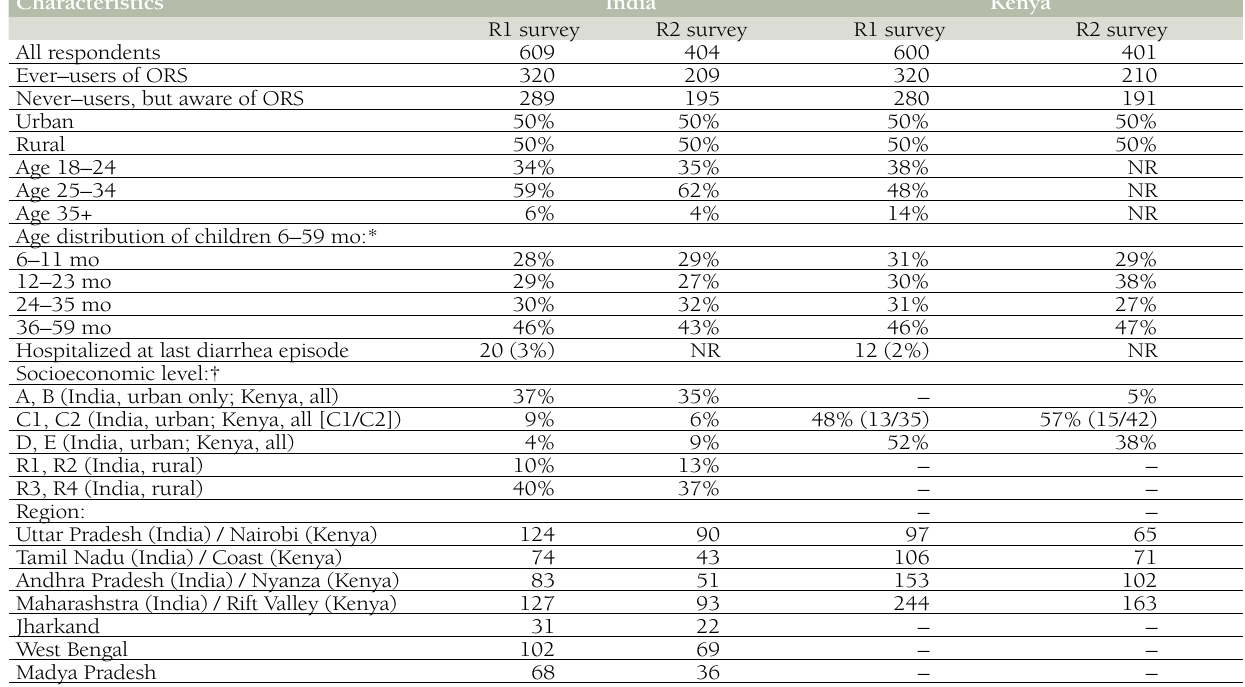
Table 1. Characteristics of the responders in two rounds of caregivers surveys (R1 and R2)